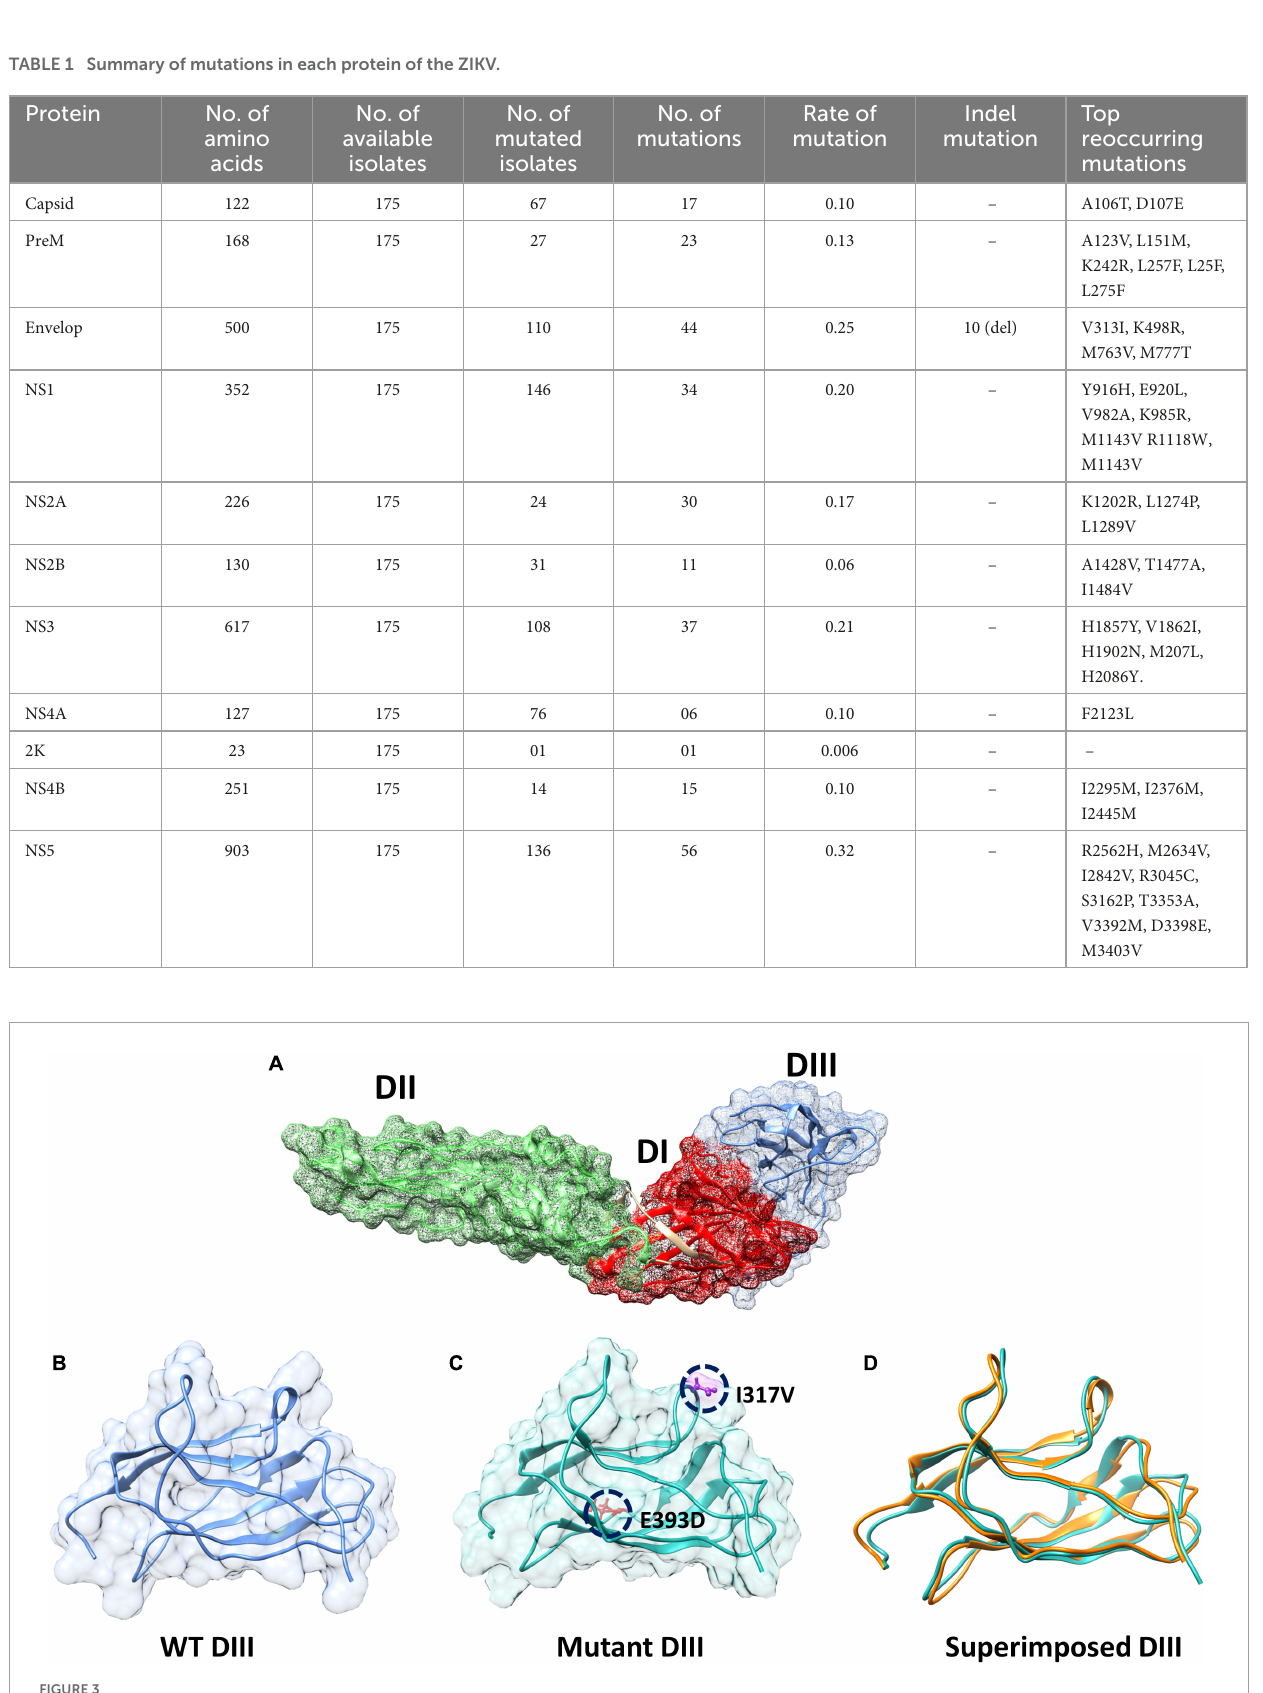
FIGURE3 Domains architecture of ZIKV E protein and mutant modeling. (A) Domain mapping of ZIKV E protein. (B) Wild-type DIII of the E protein. (C) Mutant (I317V, E393D) DIII. (D) Superimposition of wild-type DIII on mutant DIII to calculate the